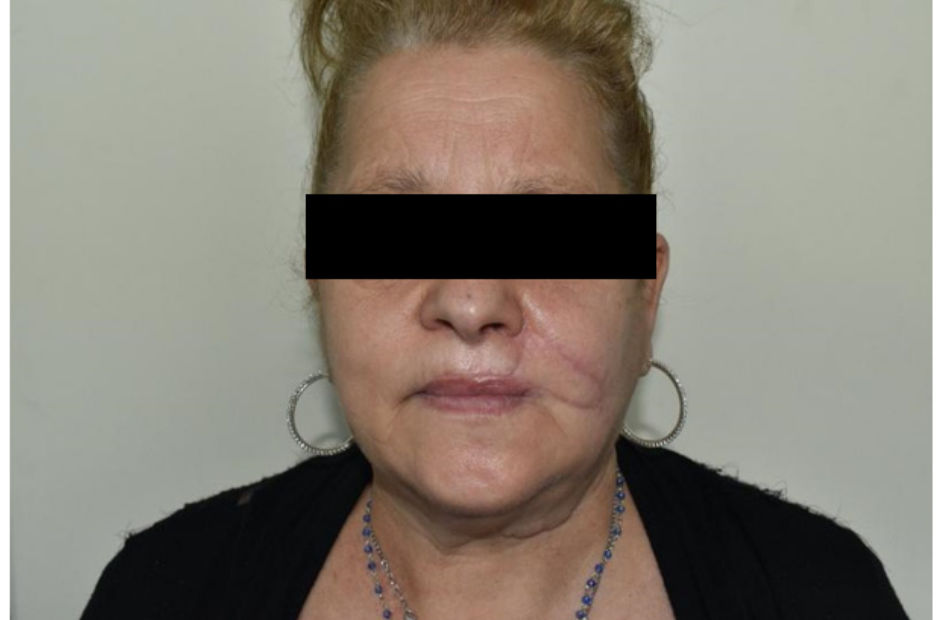
Figure 15. Case 6: Follow up at 6 months after surgery. Static position, frontal view.